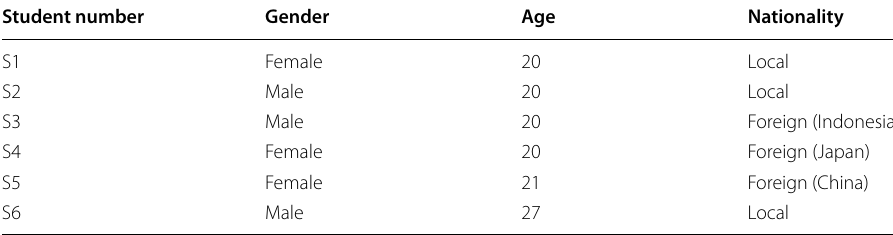
Table 2 Demographic background of respondents (qualitative